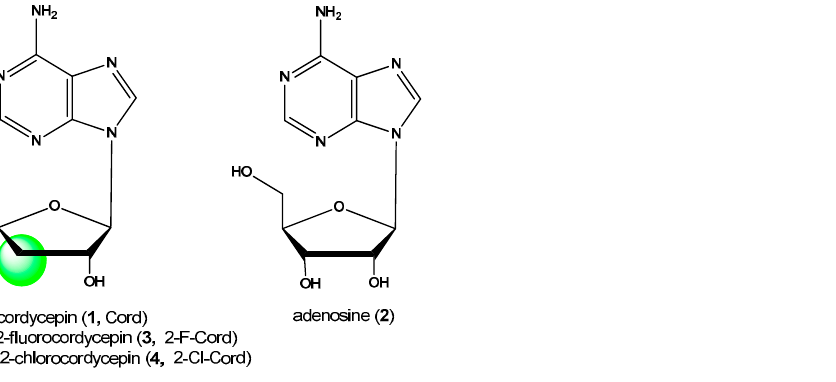
Figure 1. Adenosine, cordycepin, and their synthetic analogs.